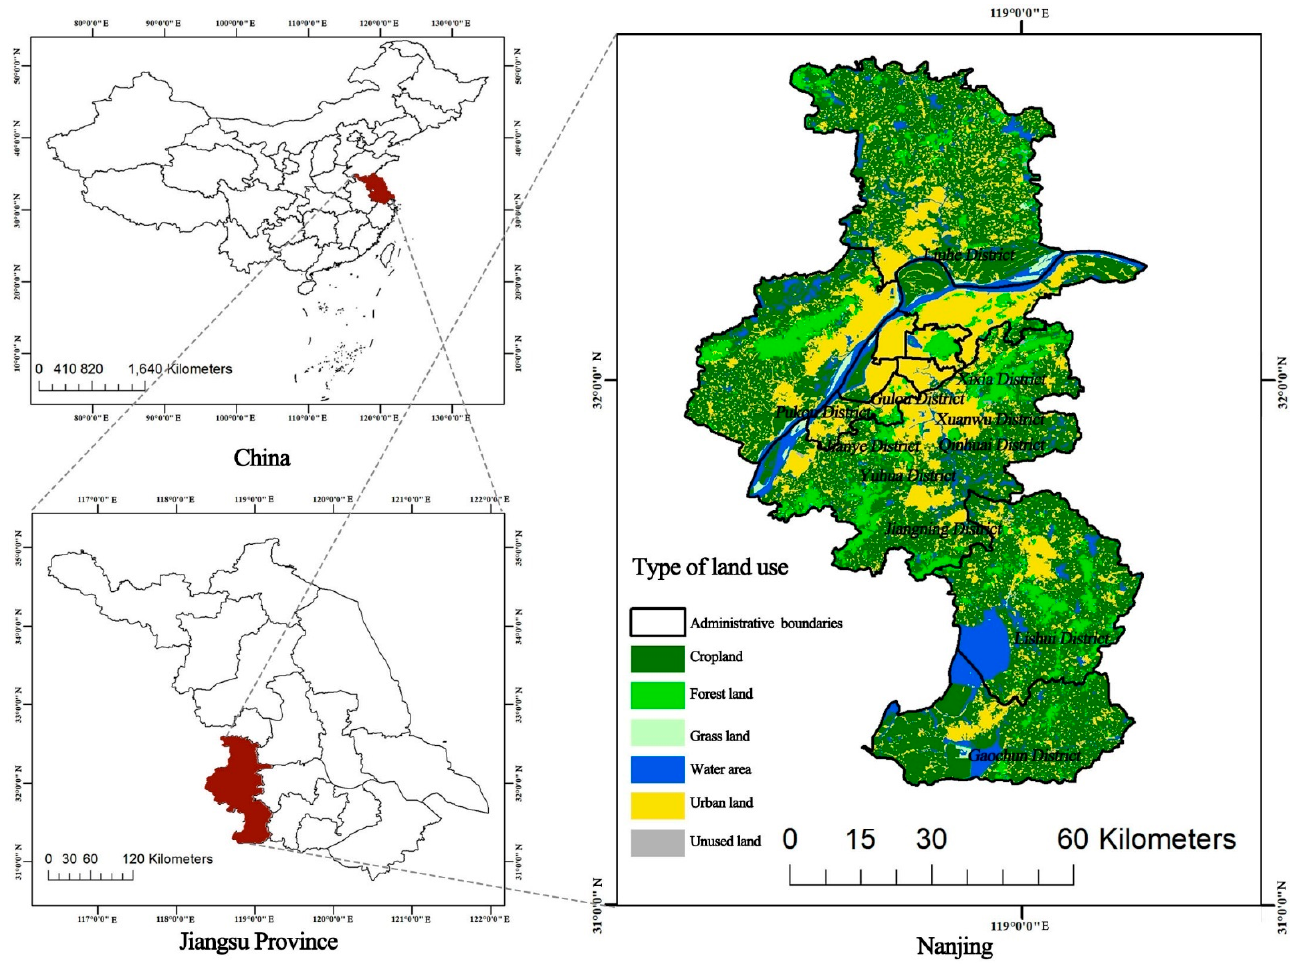
Figure 2. The study area of the